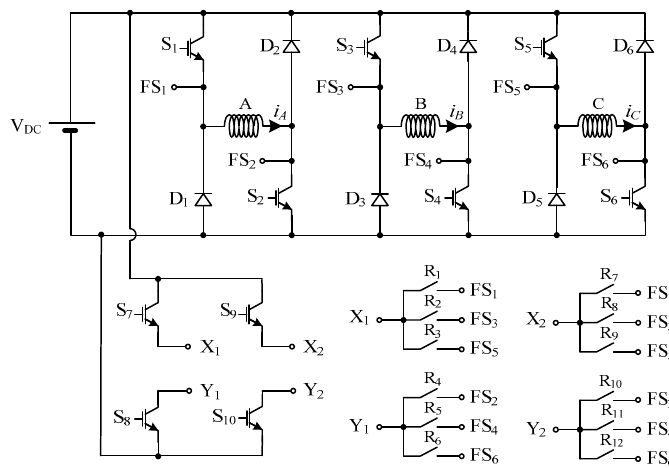
Figure 24. Fault-tolerant topology proposed by [89]. Solution using a standby single-phase full bridge of controlled power semiconductors combined with additional mechanical switches to replace up to four (two upper and two lower) faulty active switches.